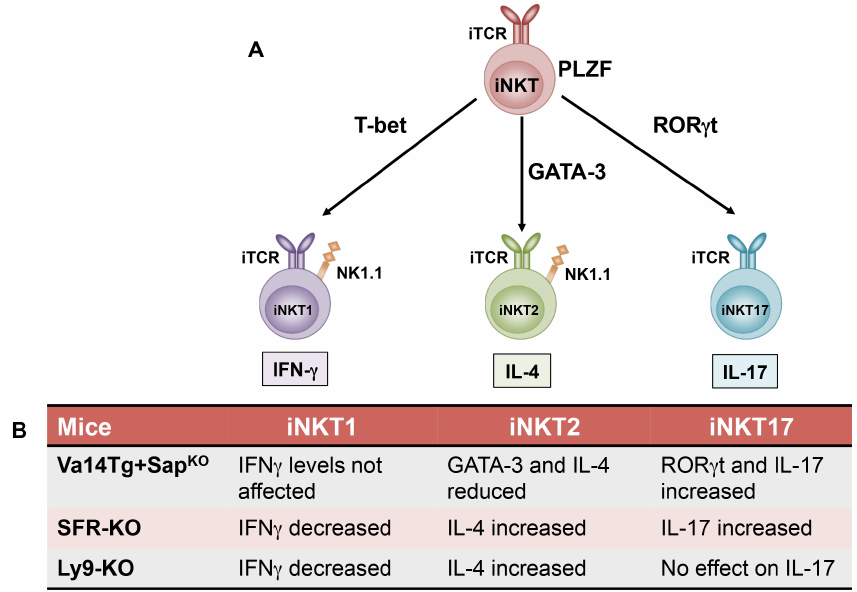
Figure 2. Invariant NKT cell lineage diversification model. ( A ) As iNKT cells develop in the thymus, they acquire their functional characteristics that is critically dependent on the transcription factor PLZF. Invariant NKT cells can be further classified into functionally distinct subsets such as iNKT1, iNKT2, and iNKT17 based on their cytokine production profile and respective expression of signature transcription factors such as T-bet, GATA-3, and ROR γ t. ( B ) Recent studies highlight a role for SLAM family of receptors (SFR KO: Lack all the 7 receptors), specifically Ly9 and SAP in the regulation of iNKT cell fate decisions and are summarized in the table. iTCR: Invariant T cell